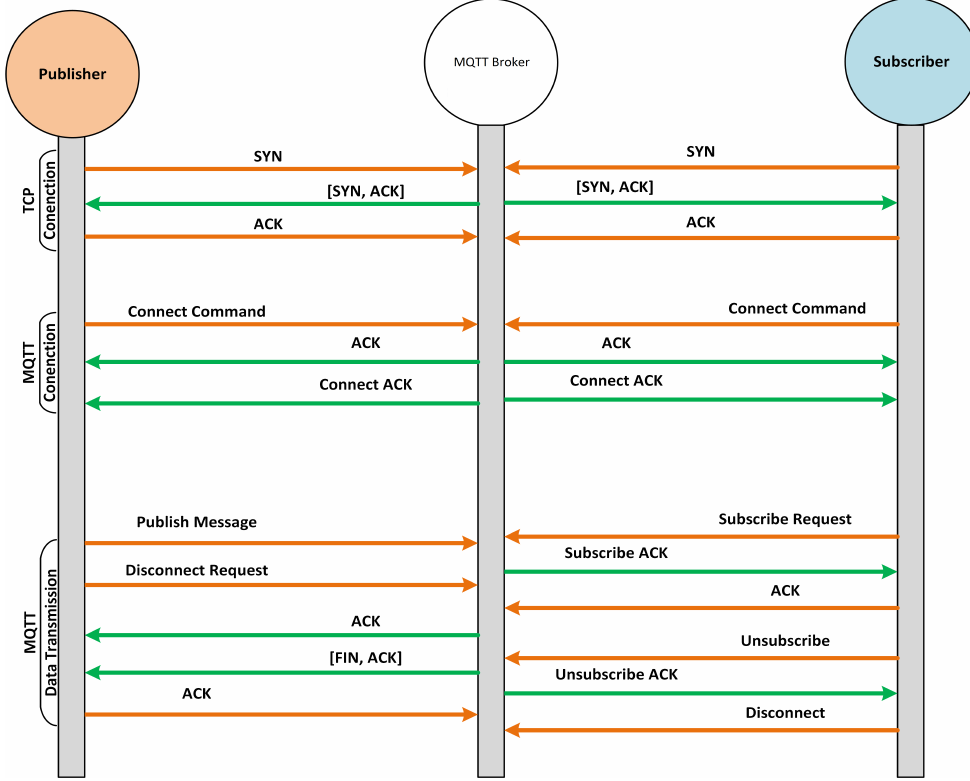
Figure 4. MQTT publish packet flow when QoS is set to 0